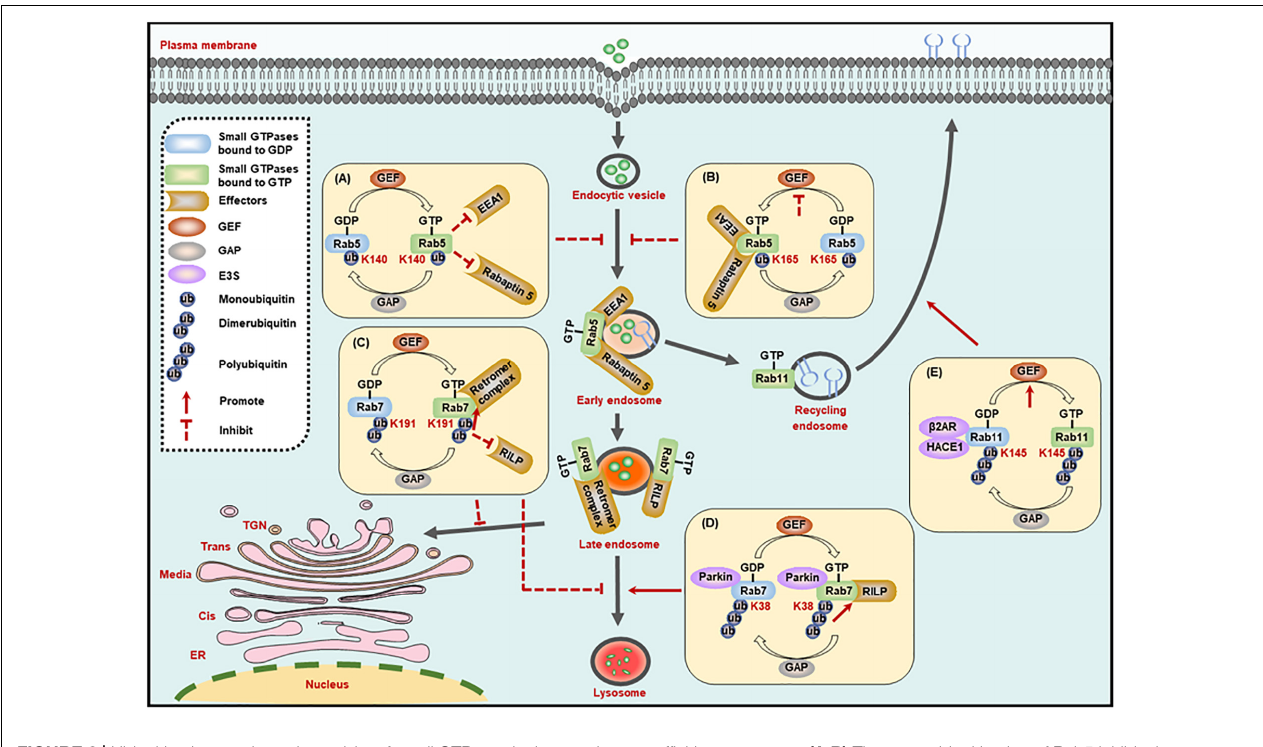
FIGURE 2 | Ubiquitination regulates the activity of small GTPases in the membrane trafficking processes. (A,B) The monoubiquitination of Rab5 inhibits its interaction with effectors (A) , or its exchange of GDP- to GTP-bound form (B) , to suppress the formation of Rab5-positive early endosomes. (C) The dimerubiquitination of Rab7 inhibits its interaction with RILP to suppress the motility of late endosomes to lysosomes, while promoting its affinity to retromer complex to suppress the recycling from late endosomes to TGN. (D) The polyubiquitination of Rab7 promotes its interaction with RILP to enhance the motility of late endosomes to lysosomes. (E) The polyubiquitination of Rab11 promotes its exchange of GDP- to GTP-bound form to enhance the receptor recycling to cell membrane. GEF, guanine nucleotide exchange factor; GAP, GTPase-activating protein; K, Lysine (Lys).